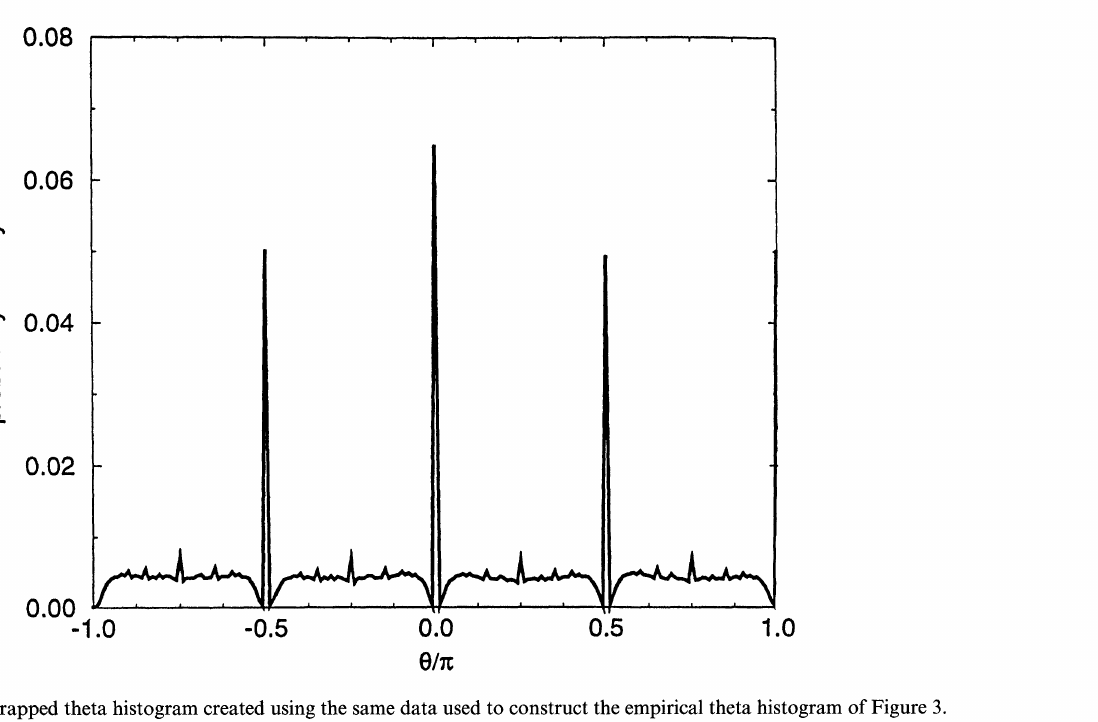
FIGURE 4 Bootstrapped theta histogram created using the same data used to construct the empirical theta histogram of Figure 3.